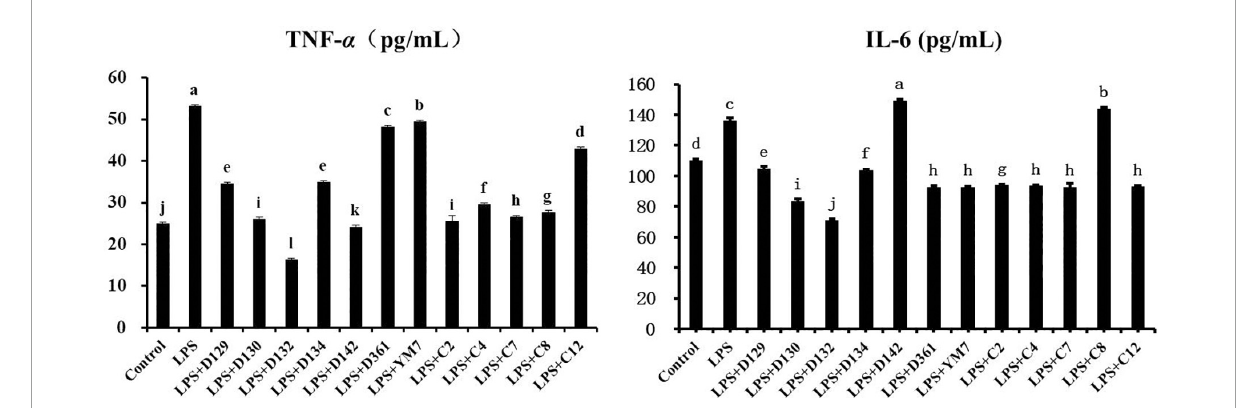
The morphologies of MDCK cells treated with hemp leaf extracts and LPS-induced inflammation are shown in Figure 2 . The MDCK cells of the control group had no change in morphology and with clear contours. The cells treated by LPS were enlarged, with increased intercellular space, and intercellular wiredrawing occurred, which affected the normal growth and adhesion of MDCK cells. To observe the protective effect of the extracts, MDCK cells were pre-treated with 0.05 mg/mL hemp leaf extracts for 4 h and then exposed to LPS to induce a slight inflammatory insult. Compared with the LPS group, the intercellular space and cell morphology of MDCK cells pre-treated by hemp leaf extracts were more similar to the control. Even though the cell morphology images of groups LPS + c2, LPS + c4, and LPS + c12 showed the cell space slightly larger than that of normal cells, it is still smaller than that of the LPS group. The results indicated that all 12 hemp leaf extracts had protective effects on LPS-induced inflammation in MDCK cells through reducing cell structural changes and damage.